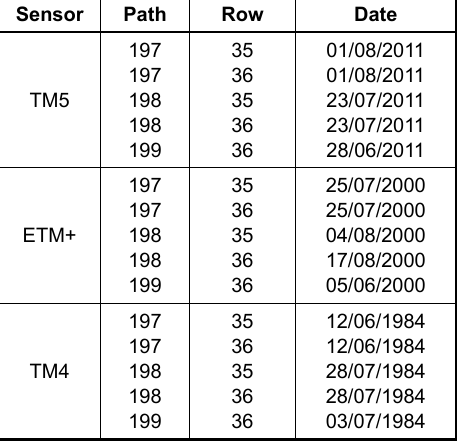
Table 1. Characteristics of data used Sensor